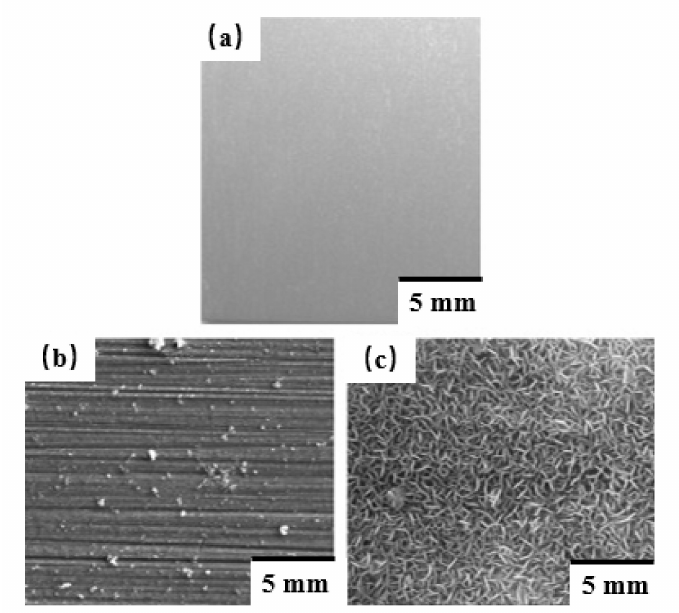
Figure 7. Images of the LDH film: ( a ) optical miscrostructure; SEM images with low magnification ( b ), and ( c ) high magnification. Reprinted with permission from [47].; Copyright 2012